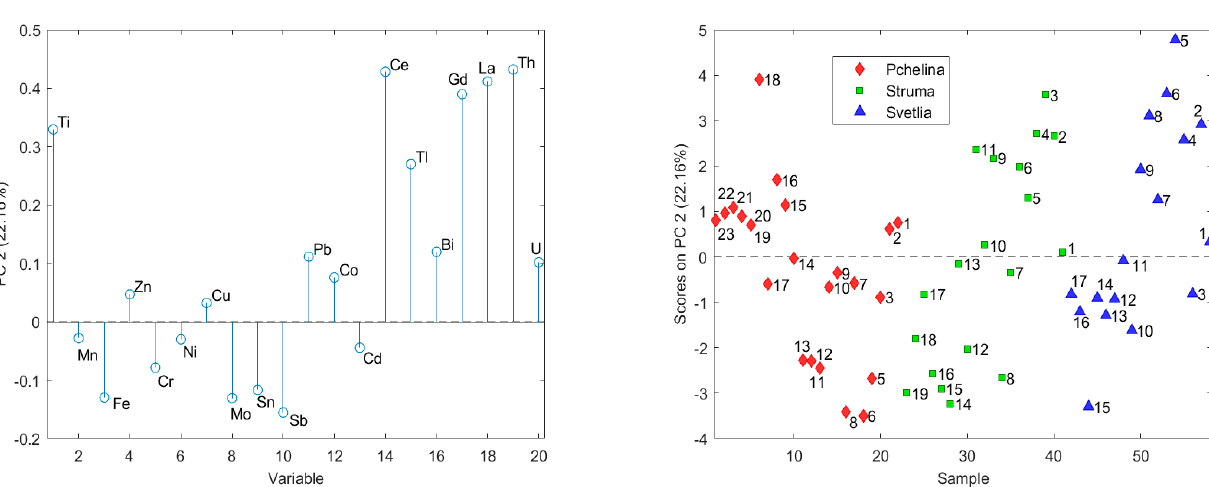
Figure 2. Factor weights and factor scores of the second principal components (the numbers on the graph indicate the historical sequence of layers in sediment core with the first (1) being the oldest).